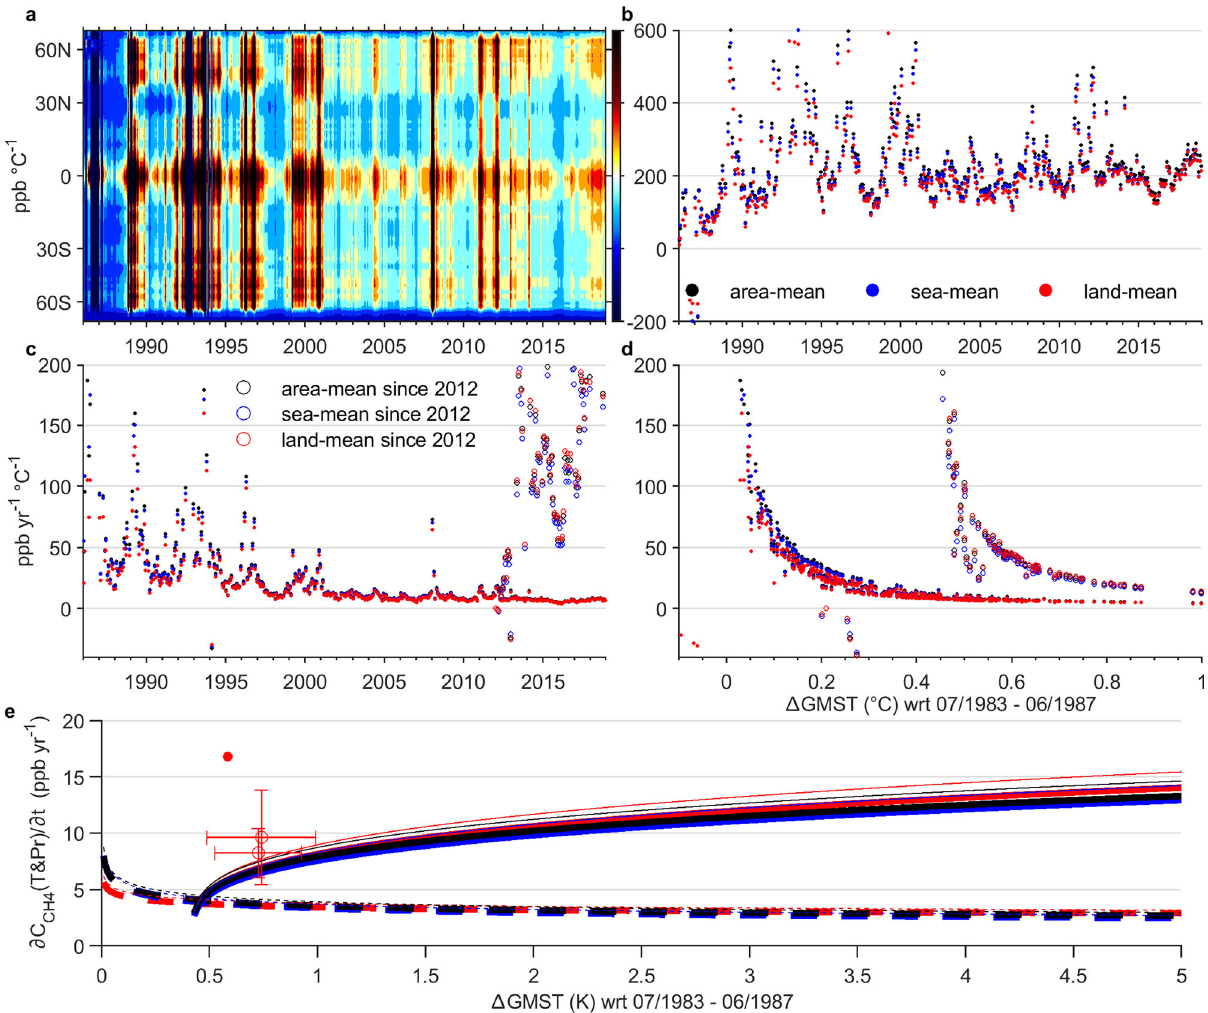
Fig. 6 Methane-climate feedback sensitivities and projected annual mean climate-feedback-contributions. Sensitivities are expressed in ppb °C − 1 ( a , b ) or ppb yr − 1 °C − 1 ( c , d ) vs time ( a – c ), latitudes ( a ), or just °C ( d ). For ( e ), the projected annual mean Δ C CH4 , climate / Δ t curves are fi tted based on values with both positive contributions and positive Δ GMST . The projected thick lines are based on extrapolation of global level sensitivities ( d ), and the thin lines are extrapolated similarly but based on a 10% higher calibration factor α . Solid and dashed lines are based on sensitivity trends since 01/2012 and 07/ 1985, respectively. The two open red circles represent preliminary estimates of Δ C CH4 / Δ t between 2020 and 2019, and between 2020 and 2018, based on a 75% of imbalance (referring to the σ in Supplementary Table 1). The respective error margins are based on two standard deviations across 12 months of the year. The fi lled red circle is based on 100% of imbalance between 2020 Dec and 2019 Dec. The 100% assumption is based on the reduced fossil fuel emissions which suggest the observed increase in C CH4 could be all driven by climate